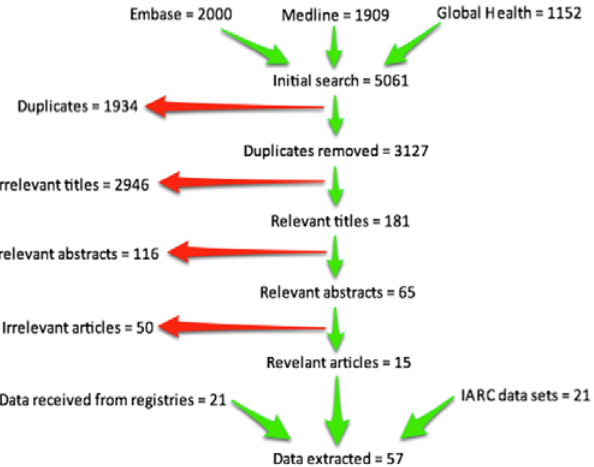
Figure 3 Definition of colorectal cancer in data sets. ICD – Inter- national Classification of Diseases (World Health